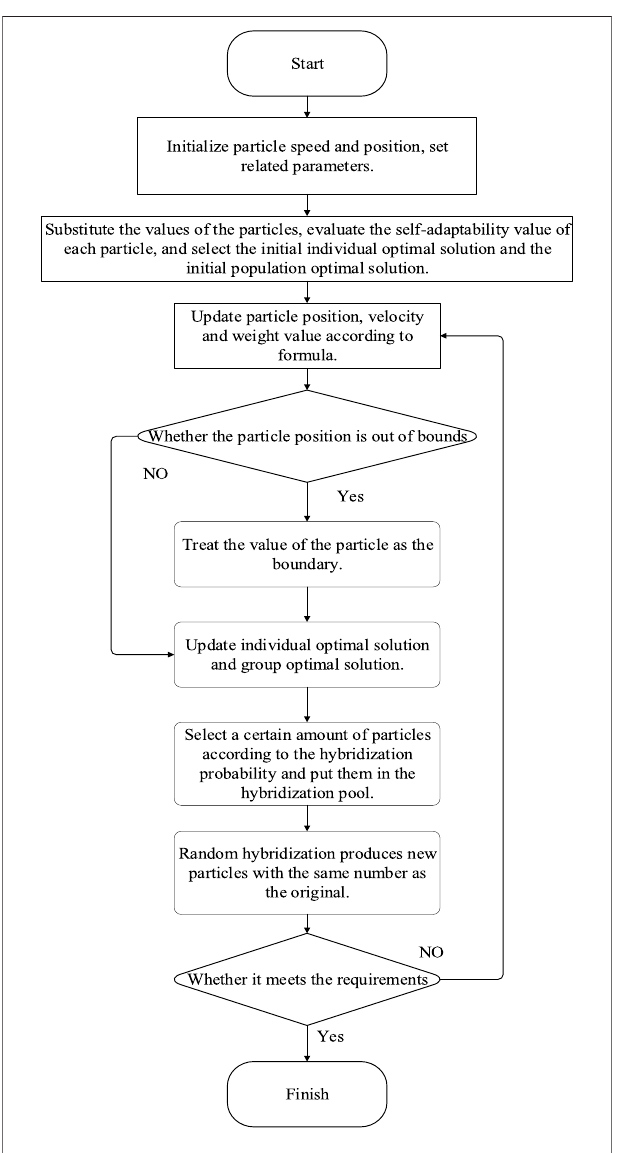
FIGURE 1 | Basic fl ow chart of the improved PSO algorithm.